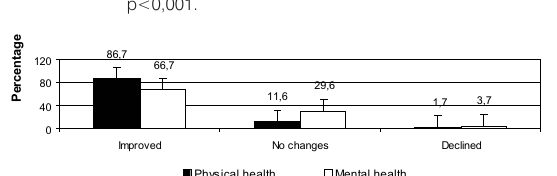
Figure 1. Changes in physical and mental health of physically active inmates after starting regular exercise χ 2 =19,026, lls=2,